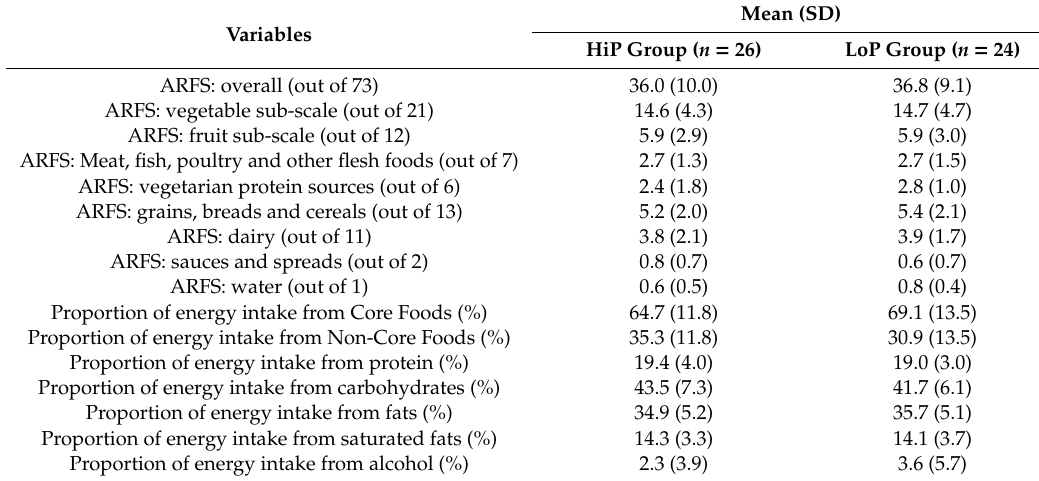
Table 2. Participant ( n = 50) baseline dietary intake.